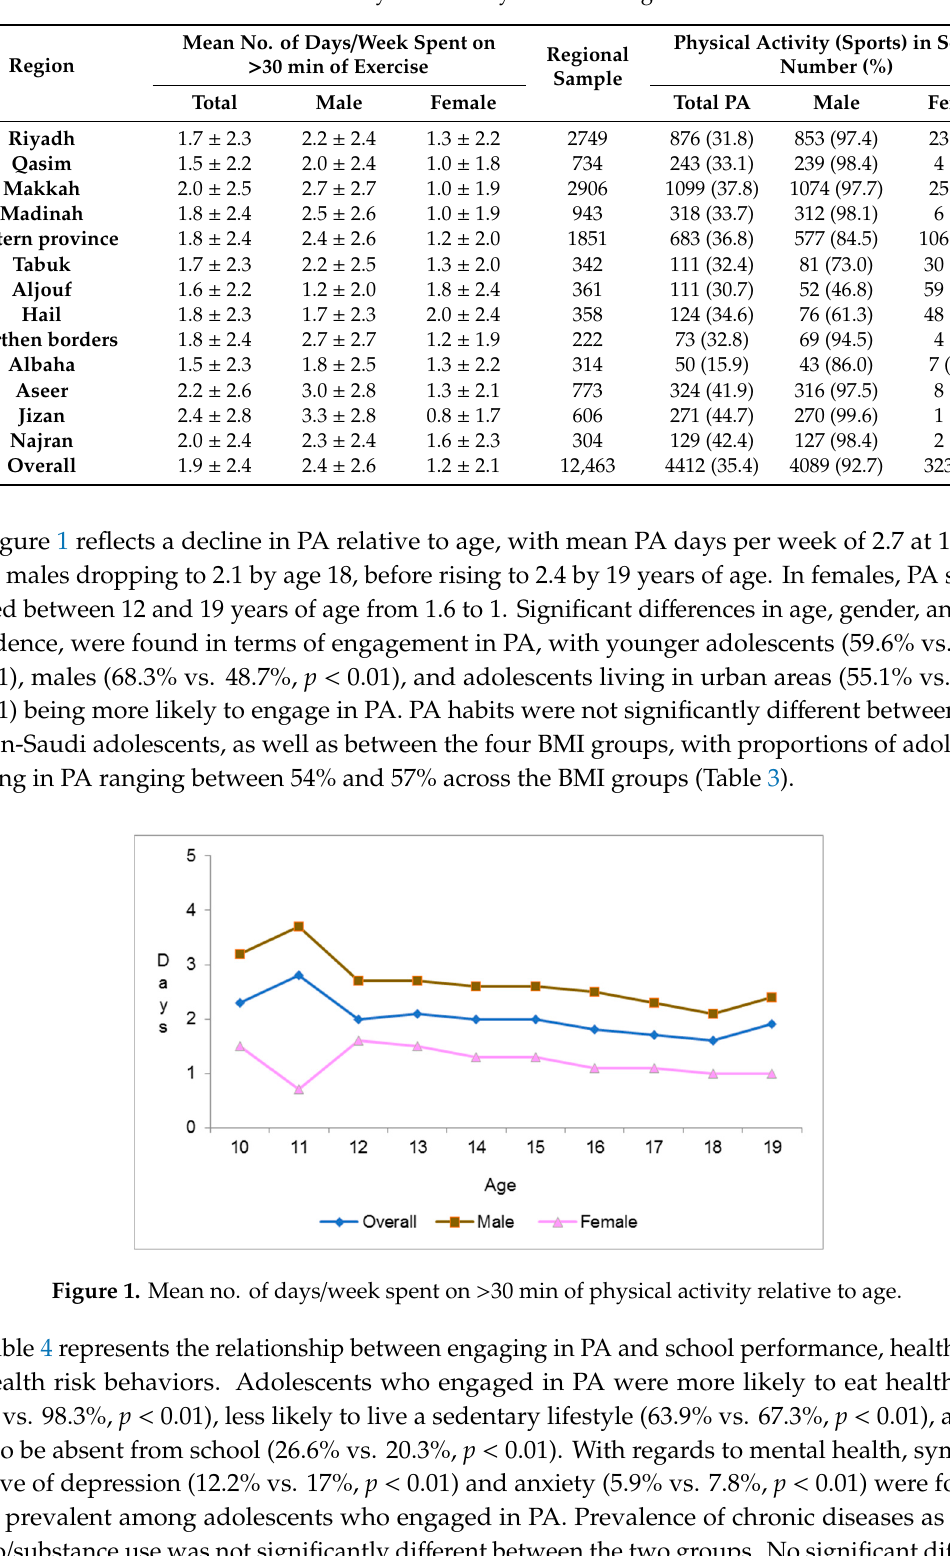
Table 2. Physical activity relative to region.